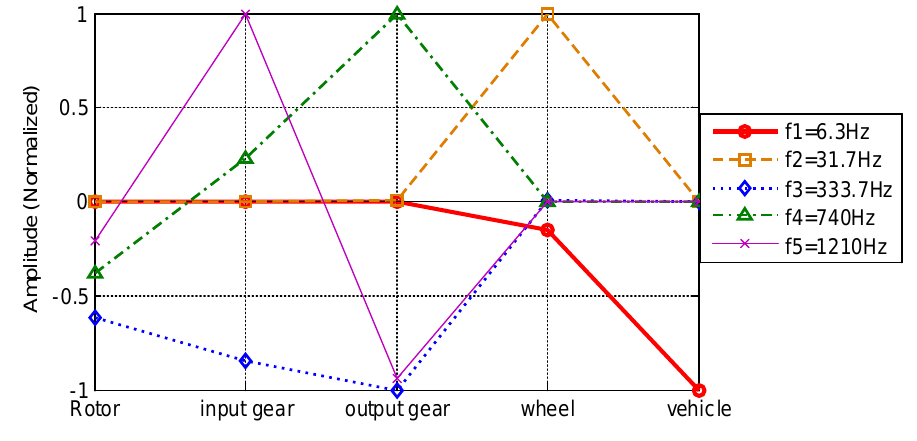
Figure 21. Normalized mode shapes of driveline.